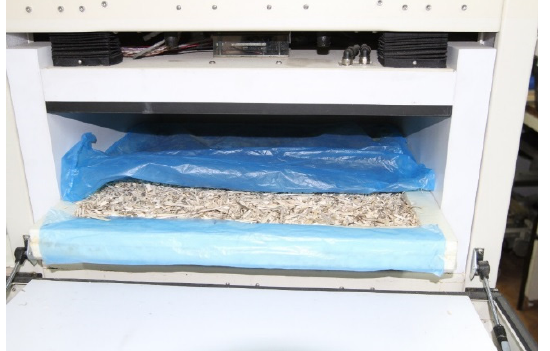
Figure 2 . Heat flow meter—Fox 602 apparatus with hemp shives sample formed in the XPS